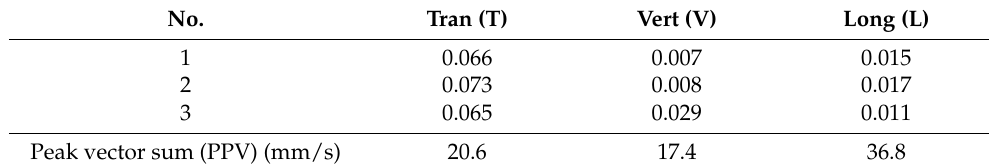
Figure 9. Fast Fourier transform results of real vibration values. At the top of each graph, the Furier spectrum value of the frequency indicated by a triangle marker is displayed. Table 3. Measured peak displacements (mm).